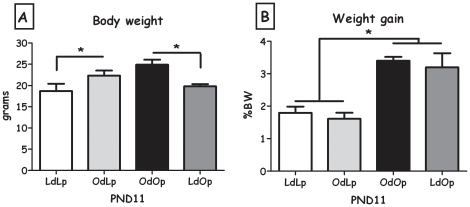
Independent ingestion test.A: Pups' body weight in grams at the time of the test (PND10-12). B: Pups' body weight gain (percentage of body weight) after the 30-min independent ingestion test. Data are presented in means and SEM. *p<0.05 for pup-strain comparison between cross and in-fostering groups. N = 6–7 per group.